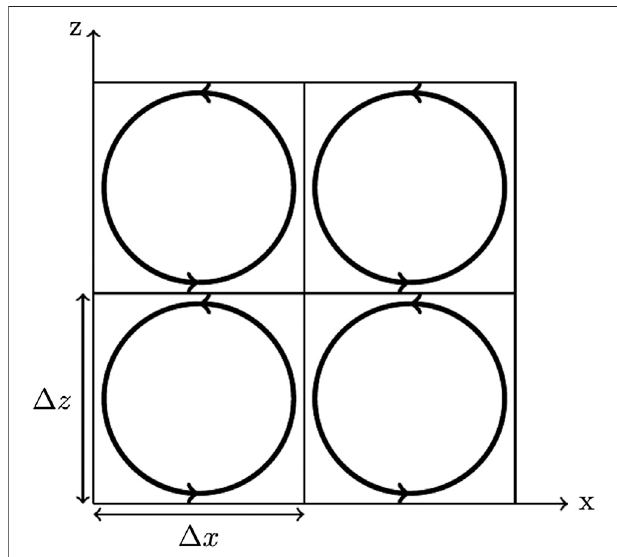
FIGURE2| Schematic turbulent eddy simulatedby alocal mixinglength in a LES grid.